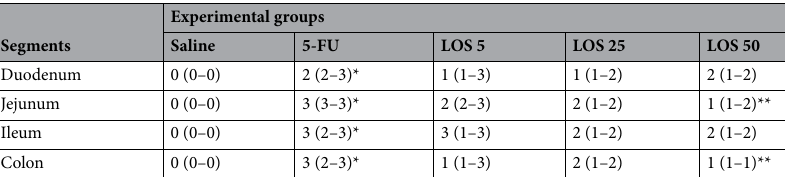
Table 1. Histological scores obtained in the experimental model of MI treated with losartan. Histological scores obtained in the experimental model of IM treated with Losartan Score data in median with respective intervals, obtained after observation of the histological slides, where scores from 0 to 3 were attributed. The data were analyzed using the Kruskal–Wallis and Dunn’s test (n = 5). *Represents p < 0.05 vs. saline group and **Indicates p < 0.05 vs. 5-FU